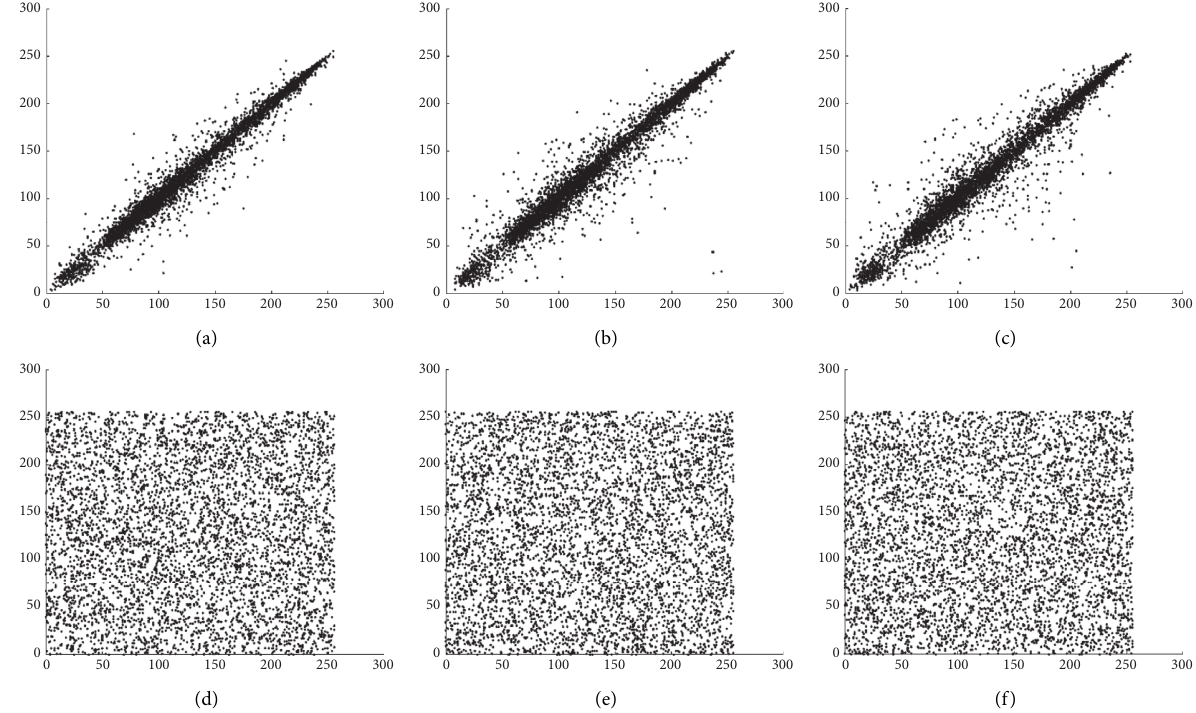
Figure 6: Correlation diagram of Lena original image in (a) horizontal direction; (b) diagonal direction; (c) vertical direction; correlation diagram of Lena encrypted image in (d) horizontal direction; (e) diagonal direction; (f) vertical